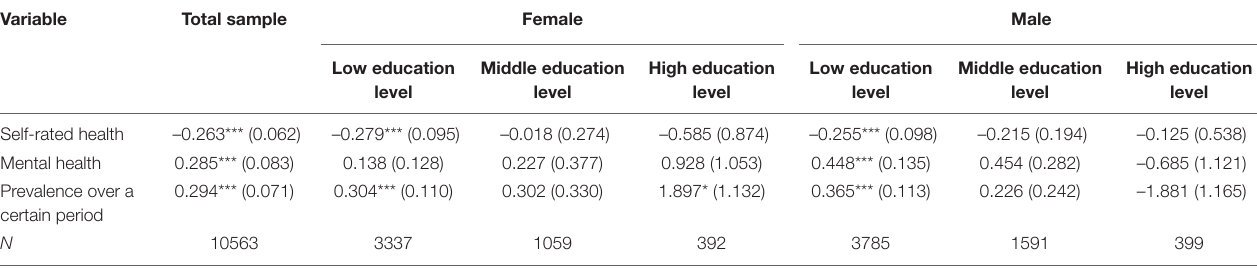
TABLE 3 | Impact of underemployment on the health of heterogeneous workers.